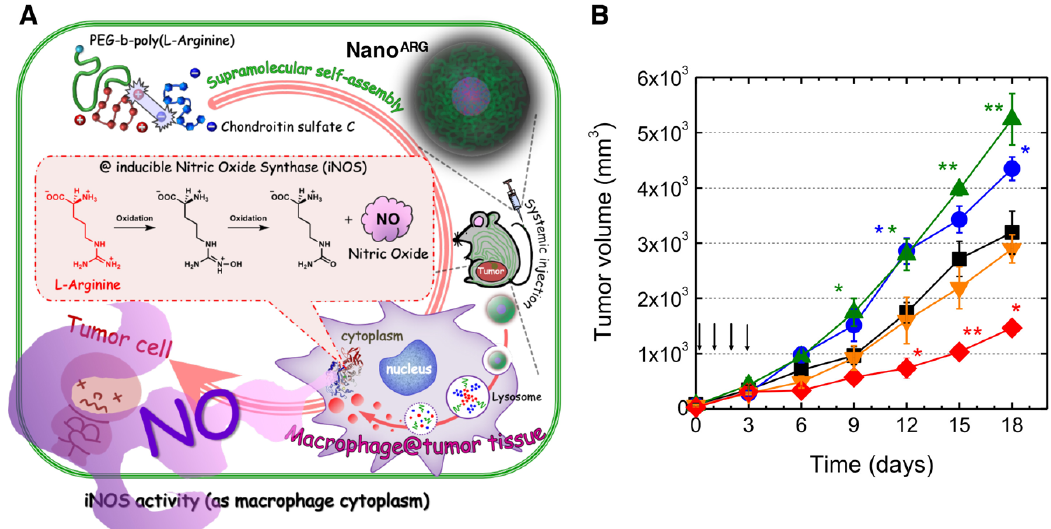
Figure 4. Development of nitric oxide-based anticancer therapeutics using the macrophage-targeted poly(L-arginine) self-assembled nanoparticles (Nano ARG ). ( A ) The strategic scheme demonstrates that the systemic administration of Nano ARG by activated macrophages leads to the generation of NO in the tumor. After intravenous injection, Nano ARG accumulates at the tumor site via the EPR e ff ect and is internalized by the macrophages, followed by the degradation to L-Arg monomer, which is converted to NO by inducible nitric oxide synthase (iNOS). ( B ) In vivo anticancer e ffi cacy in tumor-bearing mice treated with a di ff erent number of Nano ARG injections at the same dosage of L-Arg base (16 mg / kg) (1 injection: blue circle; 2 injections: green triangle; 3 injections: orange triangle; 4 injections: red diamond; untreated: black square). Reproduced with permission [59].